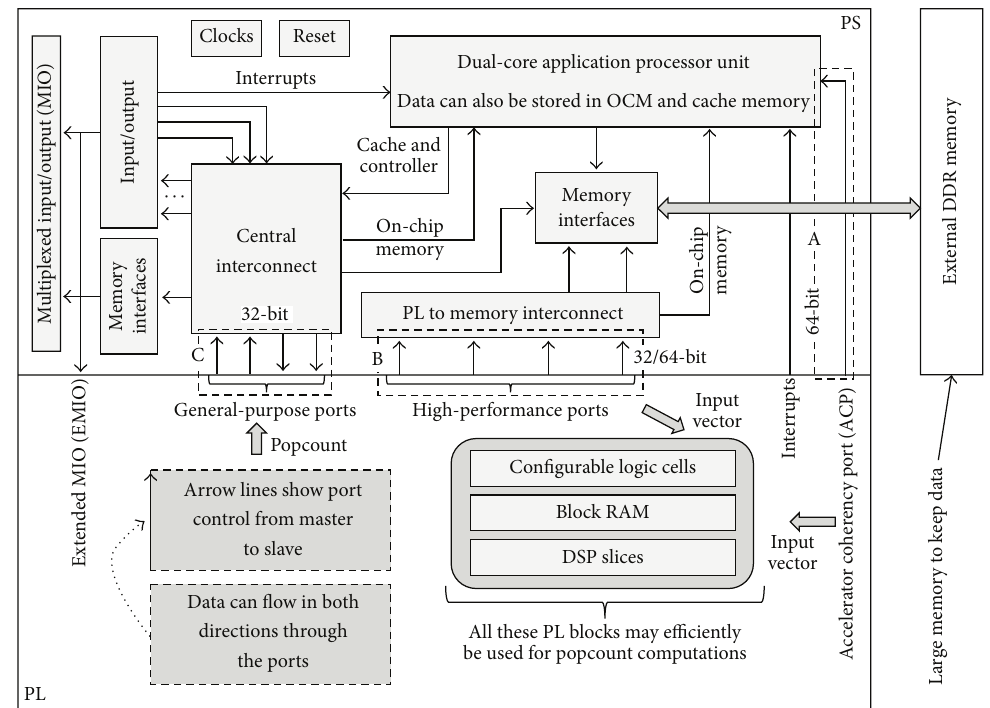
Figure 3: Interactions between the basic functional components in the Zynq-7000 APSoC.